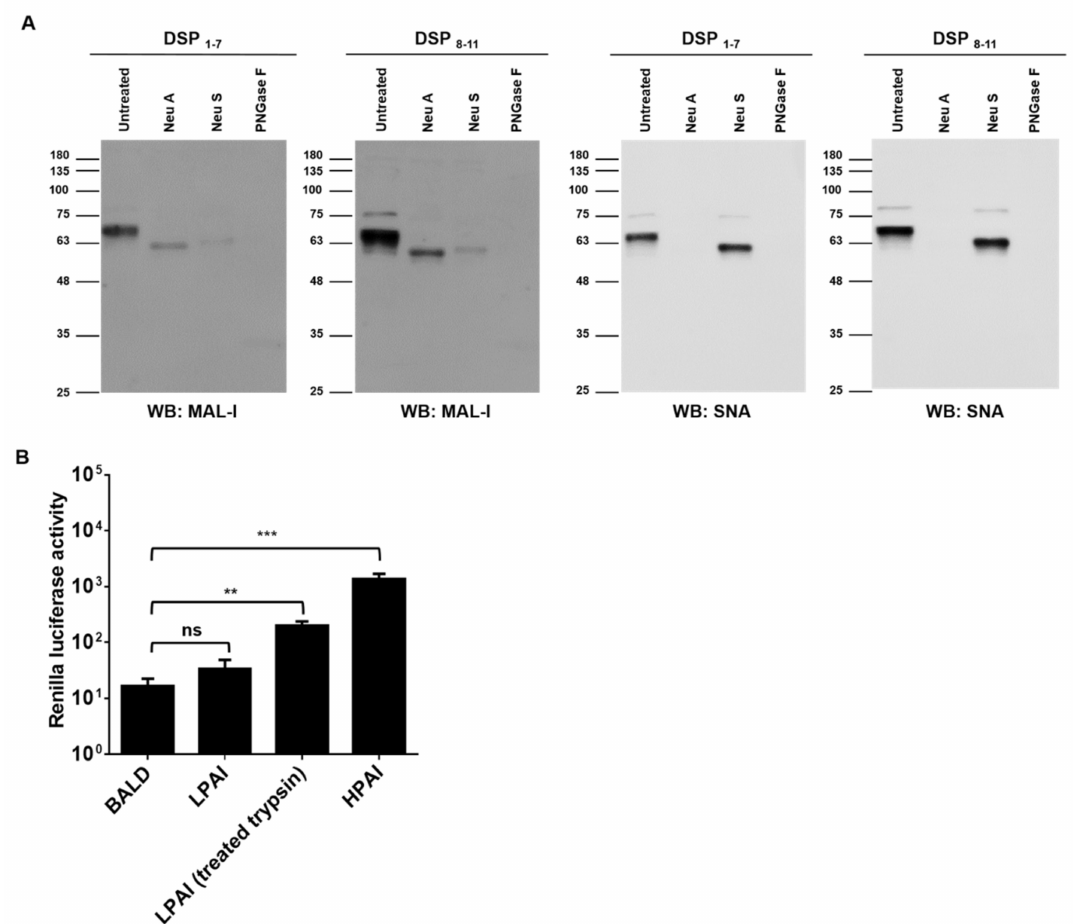
Figure 2. HPAI induced nanoparticle fusion at low pH. ( A ) Nanoparticles expressing DSPs and sialic acids were grown in HEK293T cells and incubated with neuraminidase A (Neu A), neutraminidase S (Neu S), or PNGase F for 18 h at 37 ◦ C. Sialic acids expressions were detected using biotinylated SNA or biotinylated MAL-1. ( B ) Nanoparticles expressing DSPs and sialic acids were incubated with HPAI, LPAI, or BALD pseudotyped viruses for 1 h at 4 ◦ C. Then, mixtures were adjusted at pH 5.0 and incubated with RL substrate for 10 min. Nanoparticle fusion was quantified by measuring RL activity. Error bars present SD from the mean ( n = 3). Statistical significance was assessed by Student’s t test. **, p < 0.01; ***, p < 0.001; ns, not